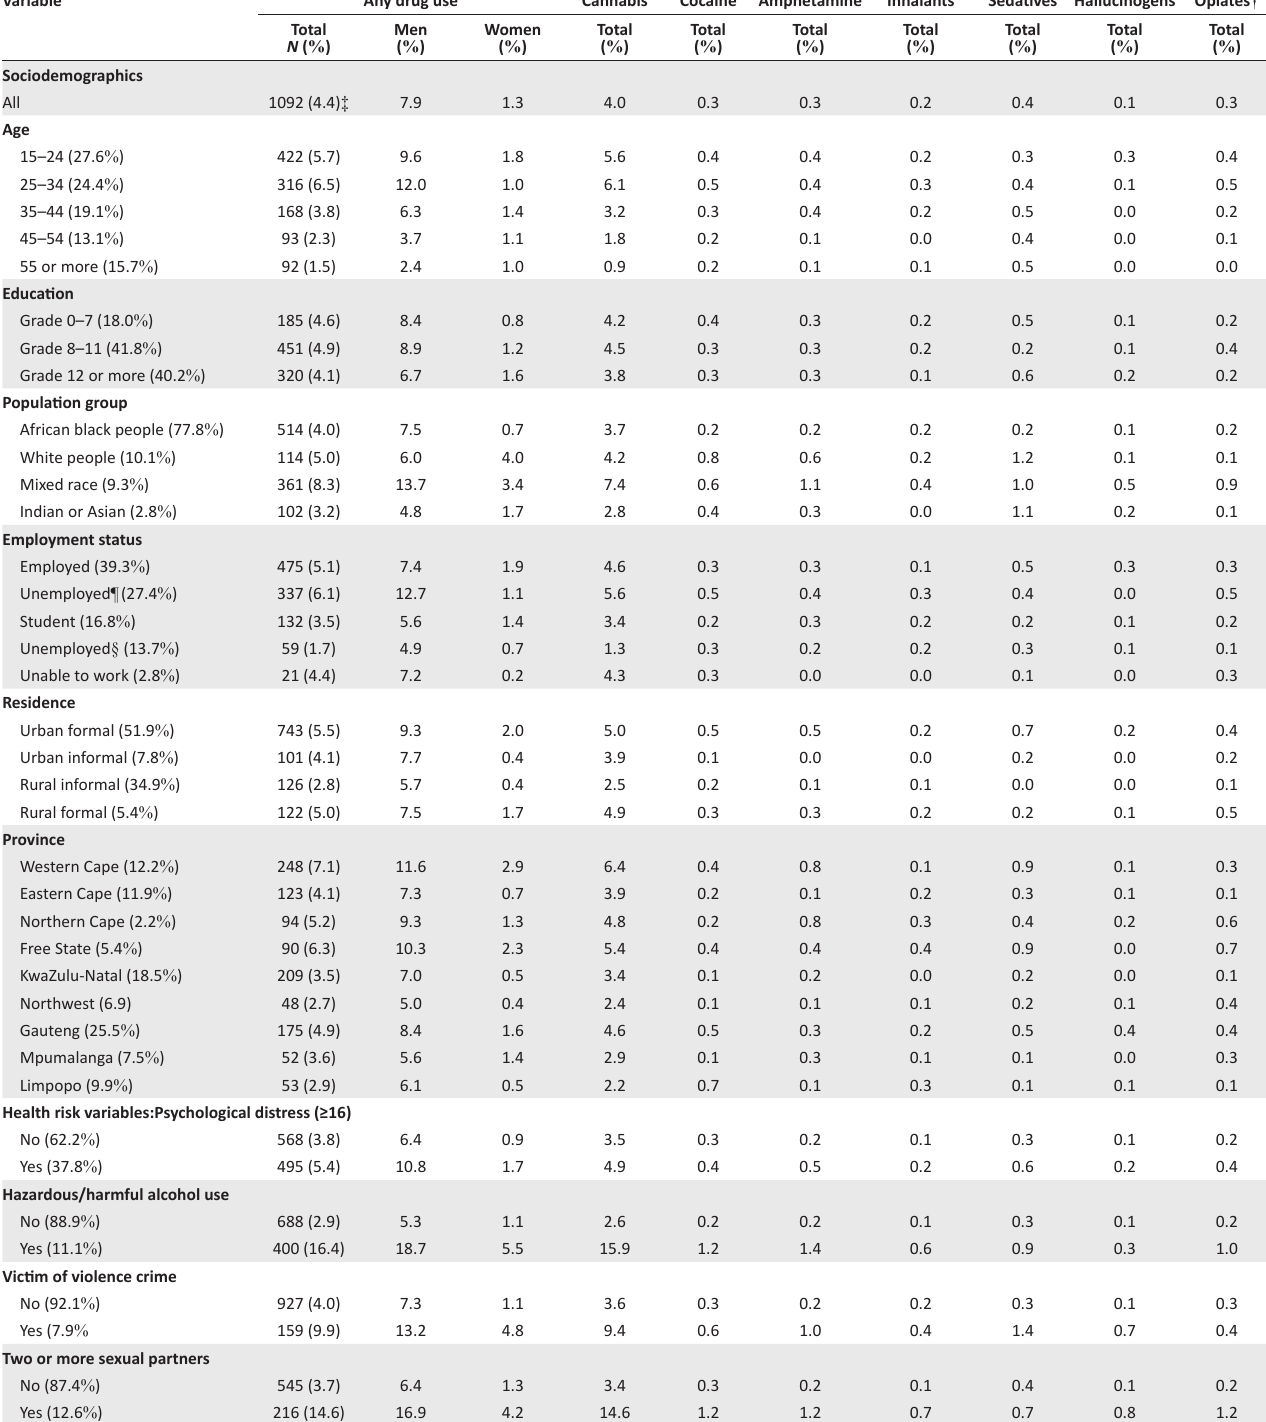
TABLE 1: Past 3-month prevalence of drug use ( N = 26